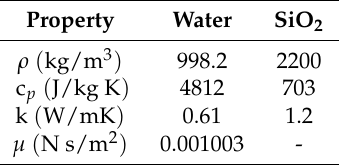
Figure 1. Schematic description of the backward-facing step geometry with boundary conditions. Table 1. Thermophysical properties of the base fluid and the SiO 2 nanoparticle